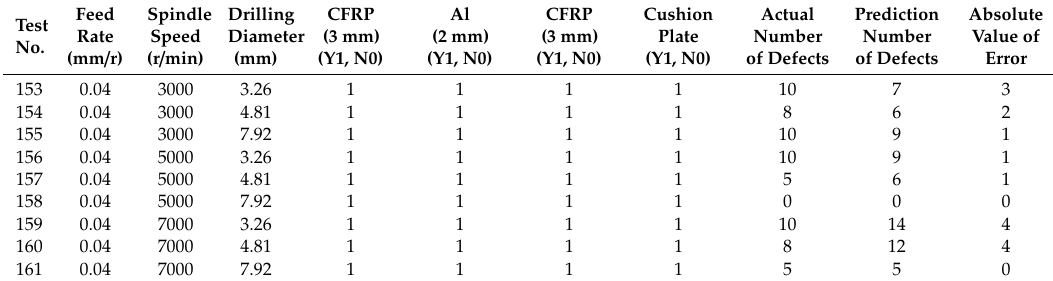
Table 5. The comparison of predicted and actual values.